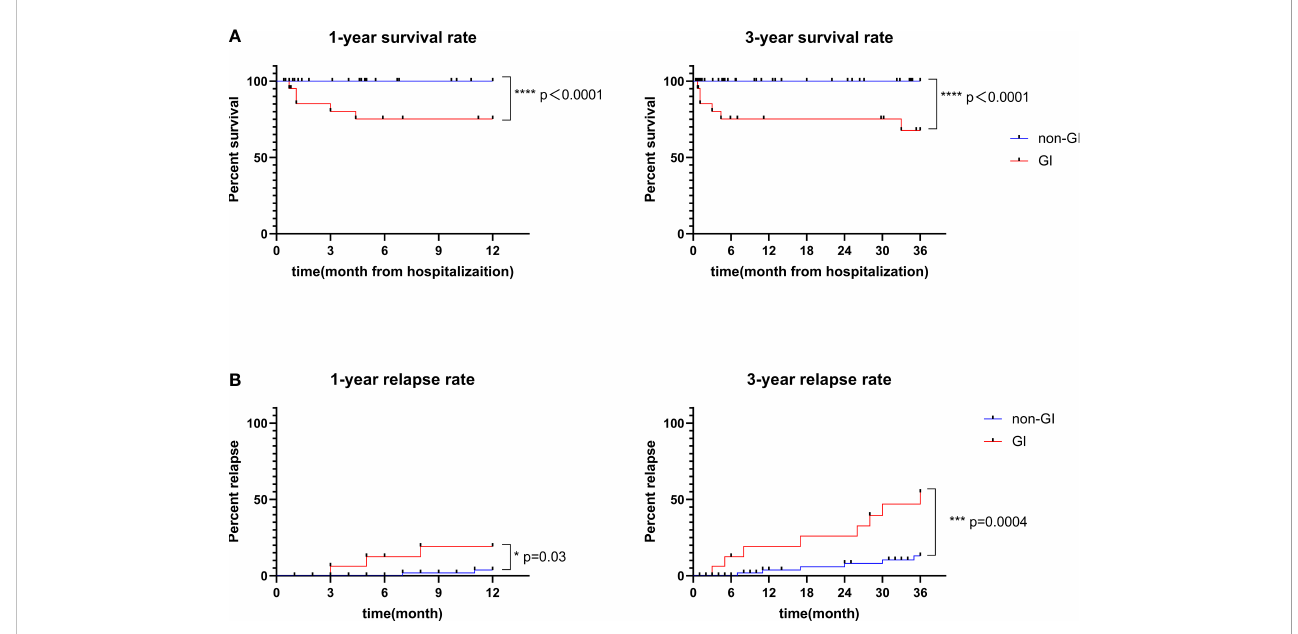
FIGURE 3 Survival rate (A) and relapse rate (B) of EGPA patients with or without GI involvement.